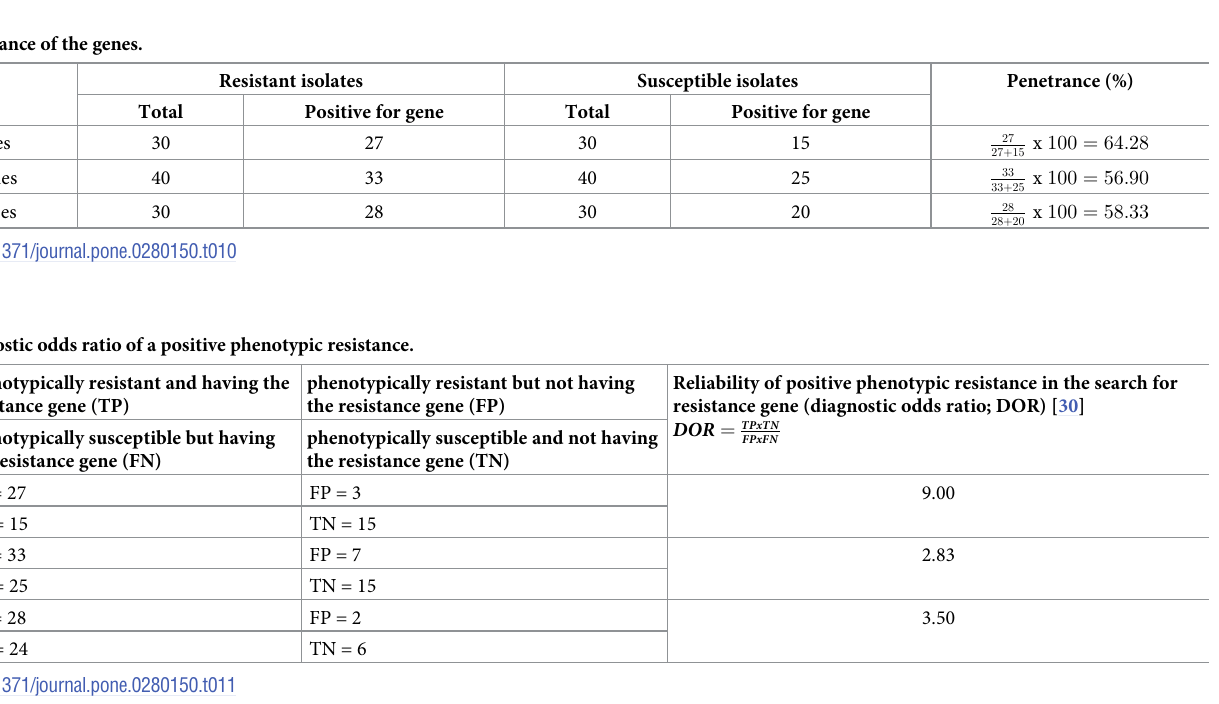
Table 10. Penetrance of the genes.